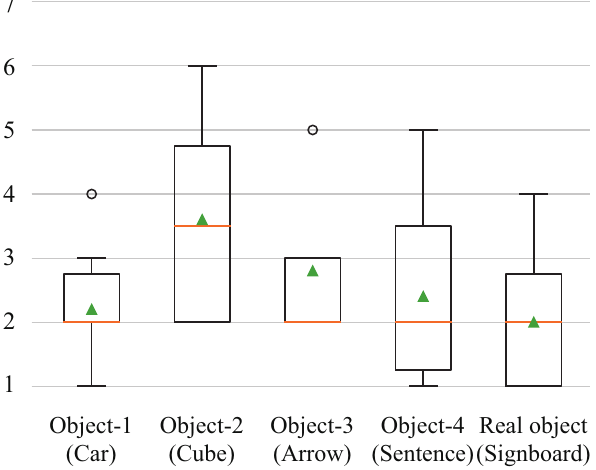
Figure 11. The result of Question-D: Did you feel uncomfortable because of the object? Comparison of the virtual objects and the real object. Comparing the results of the virtual objects (Object-1 to Object-4) with the real object (Signboard), the value of the